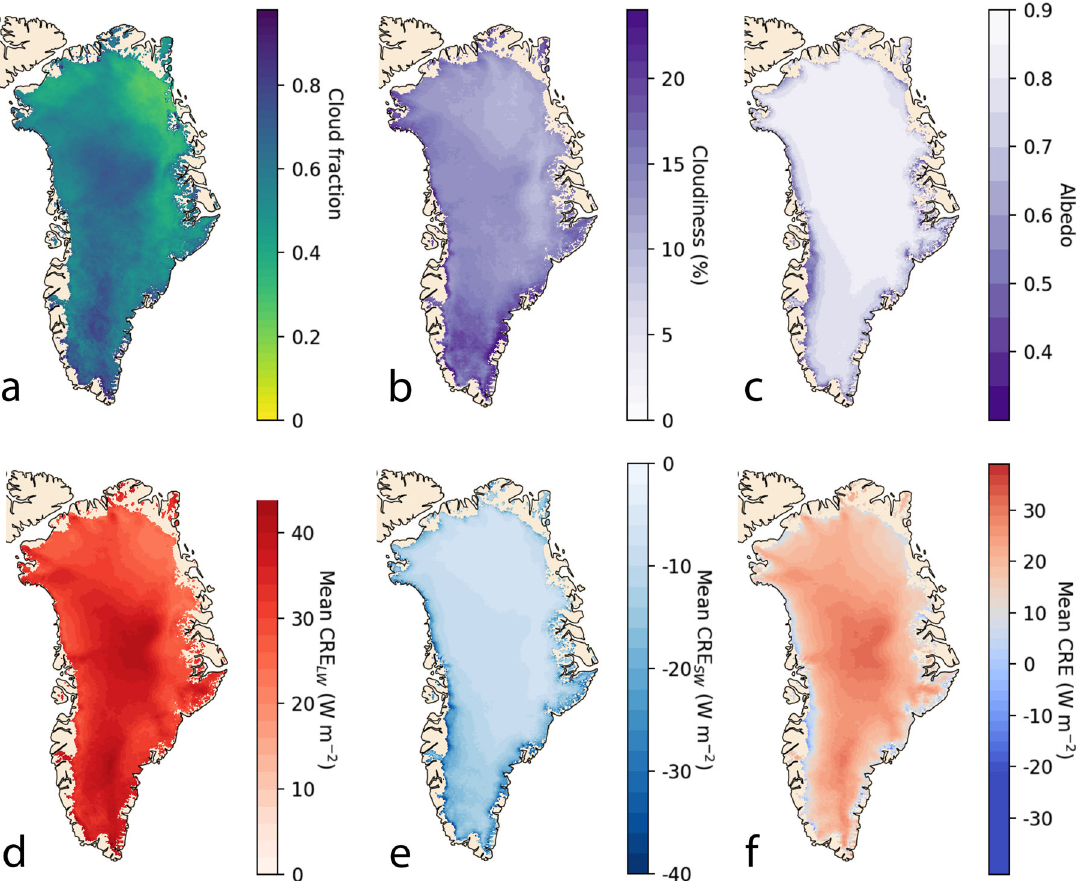
Fig. 1 High-resolution (1 km × 1 km) predictions of summer cloudiness, albedo and cloud radiative effects (CRE) over the Greenland Ice Sheet derived from fusing different satellite datasets with machine learning. a cloud fraction, de fi ned as the frequency of cloud cover ( b ) cloudiness, de fi ned as the percentage reduction of shortwave radiative fl uxes at the surface due to clouds; ( c ) surface albedo; ( d ) cloud radiative effect on shortwave radiation received at the ice surface; ( e ) cloud radiative effect on longwave radiation received at the surface; ( f ) cloud radiative effect on net all-wave radiation at the surface. This product was derived by fusing CloudSat/CALIPSO radiative fl ux and MODIS cloud and surface albedo